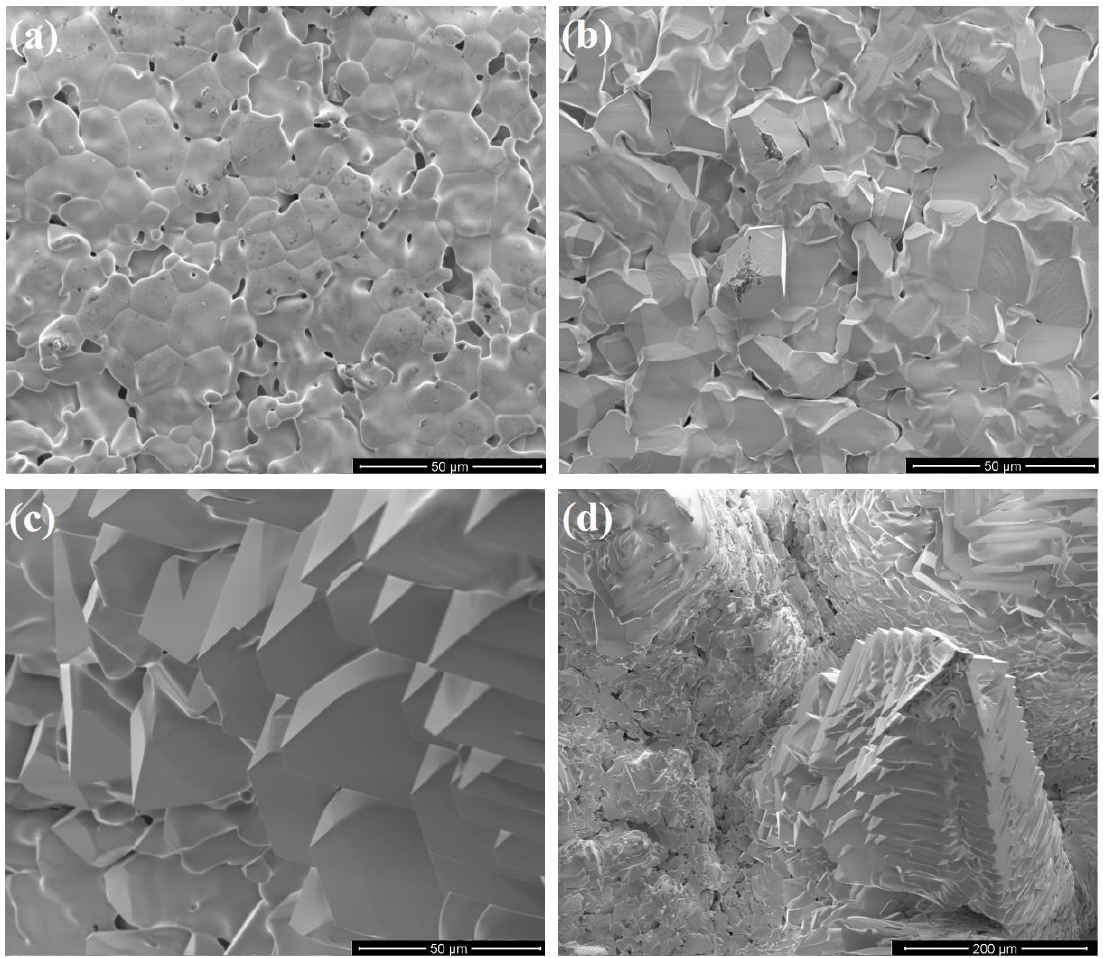
Figure 10. SEM images of the porous ceria pellet after 10 cycles: ( a ) near the edge; ( b ) between the edge and the center; ( c ) near the center; ( d ) near the center with low magnification. All images are at 1000 × magnification except ( d ), which is at 250 × magnification.